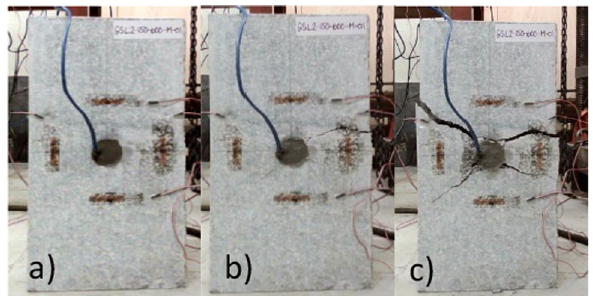
Fig. 13 G-SL2-150-600-M-01 a At time t Complete breakage t 10